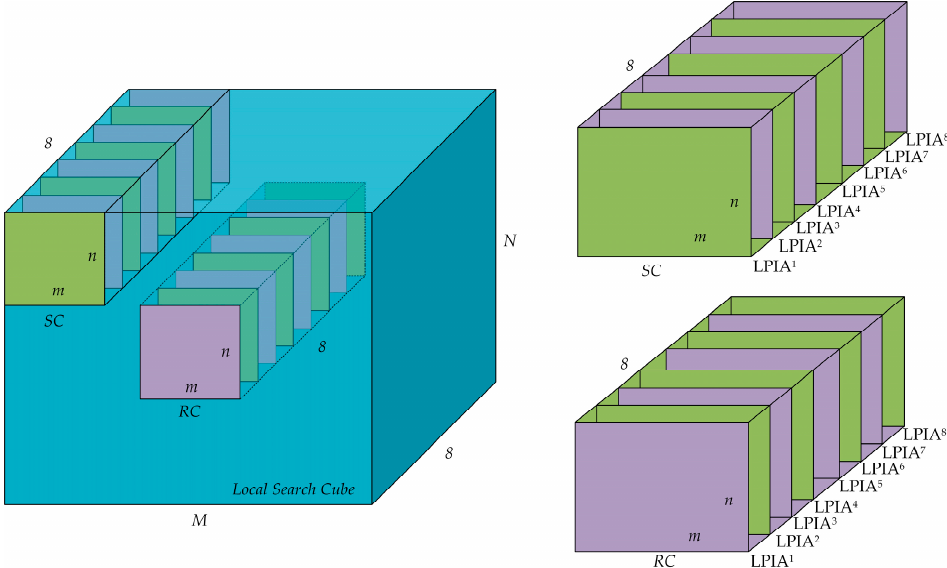
Figure 3. Schematic diagram of cube similarity based on MDLPIA.